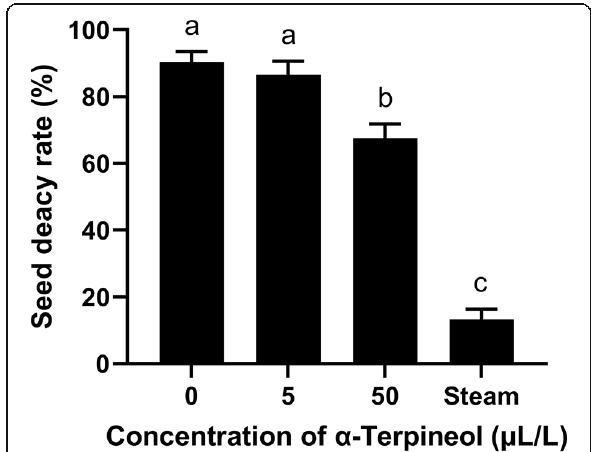
Fig. 2 Effects of α -terpineol fumigation on seed decay rate in soil consecutively planted with Panax notoginseng . The consecutively planted soil was fumigated with α -terpineol at concentrations of 0, 5 and 50 μ L/L. Steam indicates treatment of soil with steam at 121 °C for 15 min, which was used as a positive control. Data are presented as the mean ± SE, bars indicate SE, and different letters indicate significant differences analyzed by one-way ANOVA with Duncan ’ s multiple range test, P < 0.05